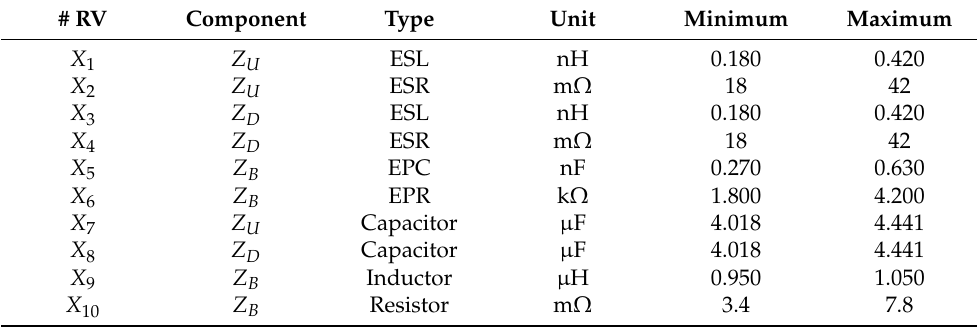
Table 1. UQ with RVs Uniformly distributed involved for test case #1 (Channel #1).